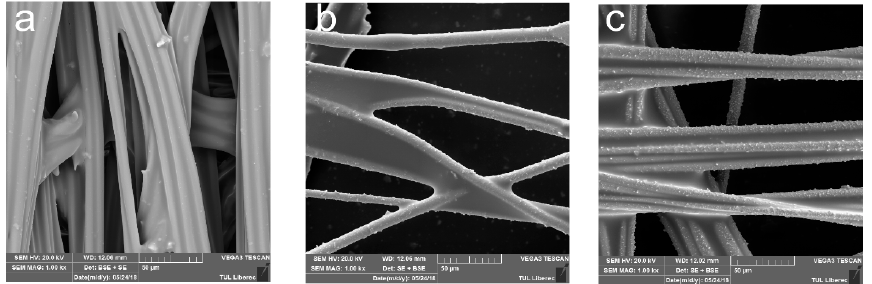
Figure 4. Microscopic images of Cu/Ni-coated Milife fabric ( a ) sample N0; ( b ) sample N5; ( c ) sample N8.